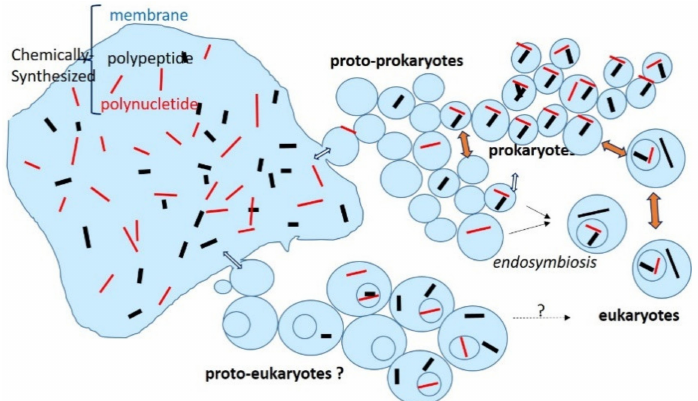
Figure 2. Possible early origin of communications between proto-prokaryotes, prokaryotes, eukaryotes, and hypothetical